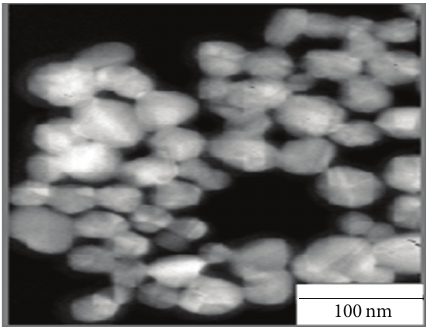
Figure 2: TEM image of the silver